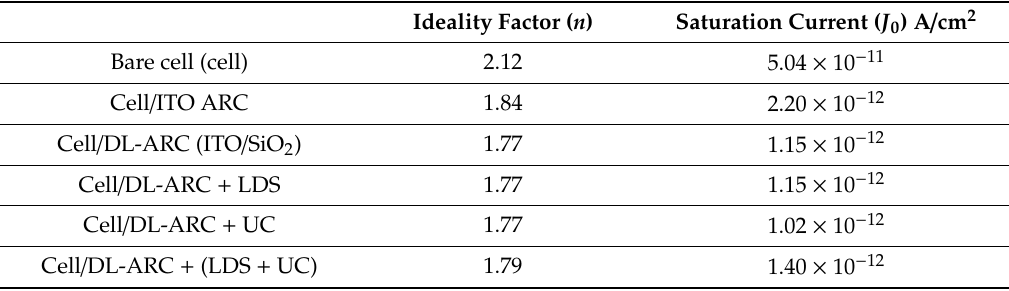
Table 2. Ideality factor ( n ) and saturation current density ( J 0 ) of bare-type GaAs solar cell and GaAs solar cells coated with ITO, ITO / SiO 2 layer, or SiO 2 layer containing Eu-doped phosphor.